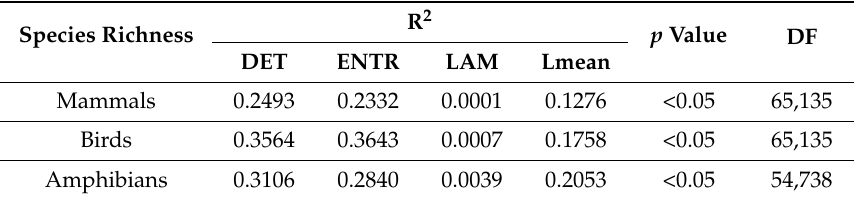
Table 2. Correlation coefficients between the species richness from field surveys and the temporal stability of ET using a simple linear regression of the raw data.